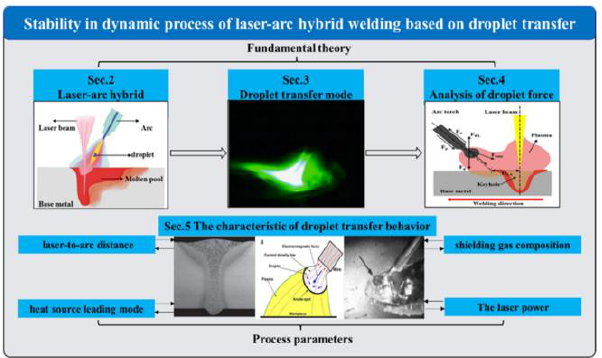
Figure 2. The schematic diagram of content framework in this review.